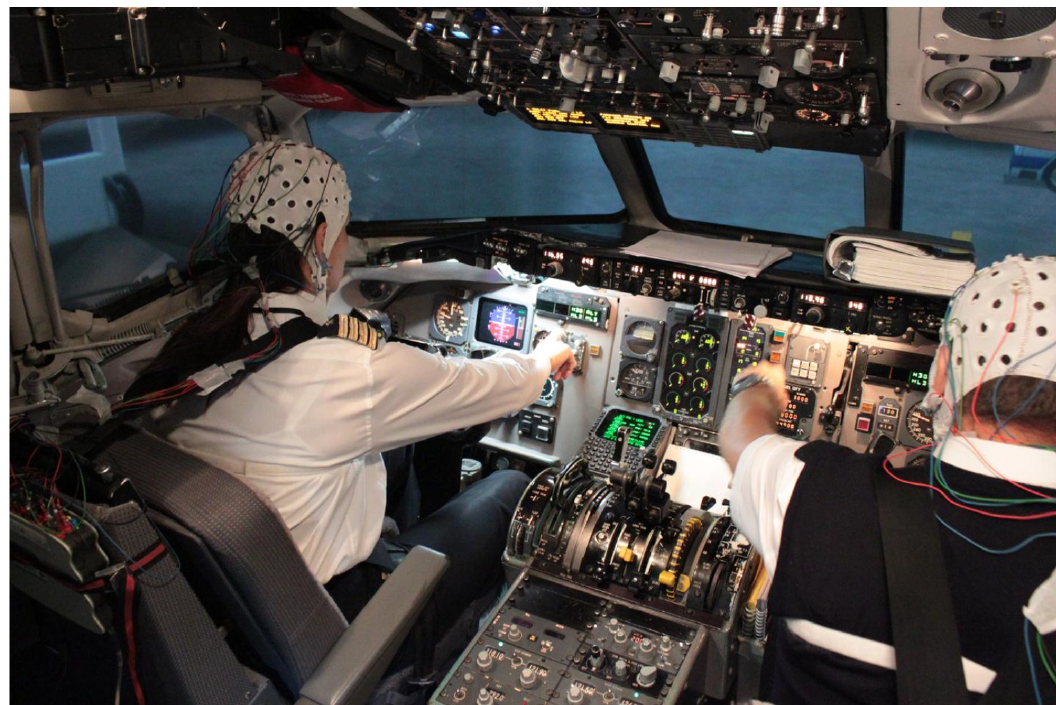
Figure 5. A real-world study paradigm, as demonstrated by